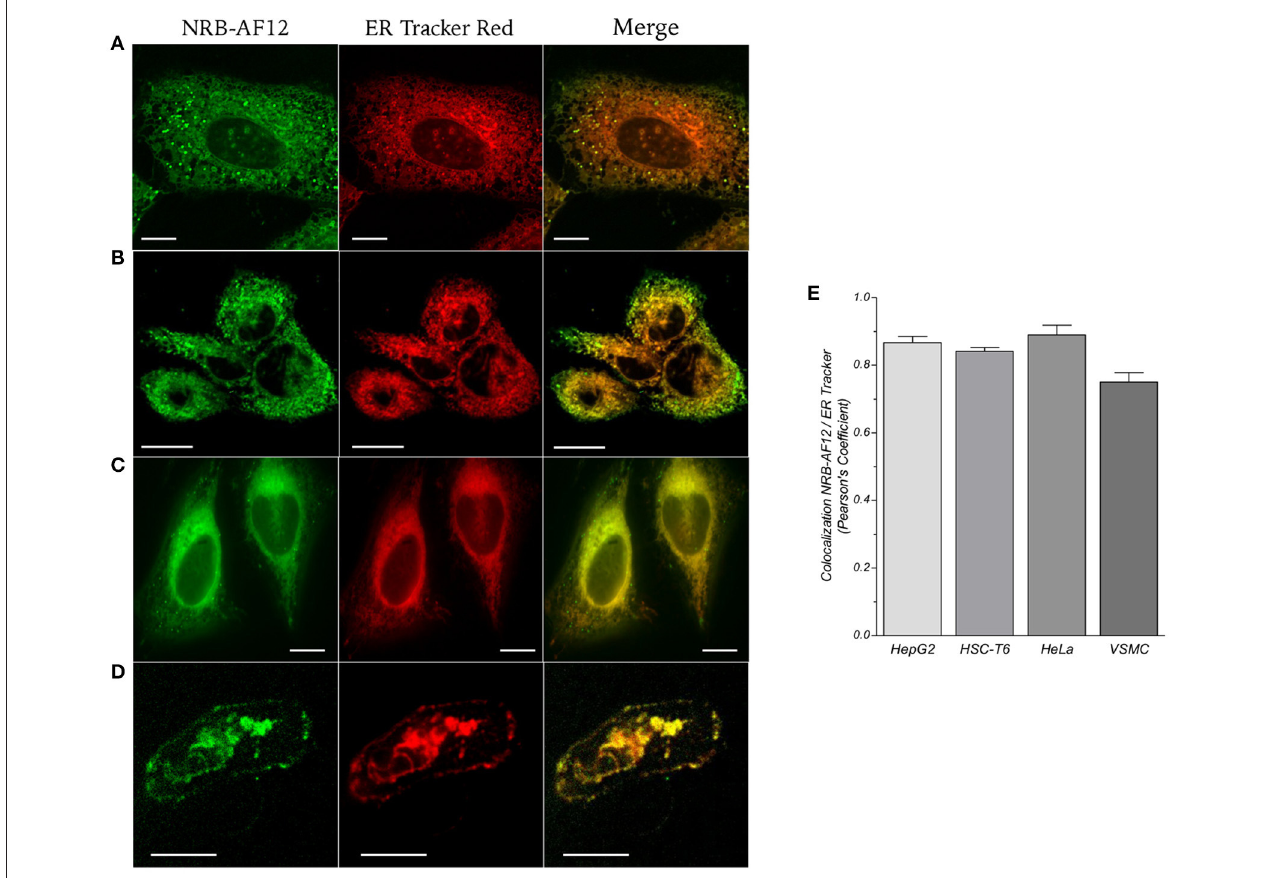
FIGURE 4 | Representative live cells microphotographs showing co-localization between NRB-AF12 (left column) and ER-Tr red (mid column) in (A) HepG2, (B) HSC-T6, (C) HeLa, and (D) primary rat vascular smooth muscle cells (VSMC) from caudal artery. For each panel, merged fluorescence is shown in right column. Magnification 60x; scale bar, 10 µ m. (E) Quantification of NRB-AF12 and ER-Tr co-localization is shown as Pearson’s coefficient (n ≥ 15).